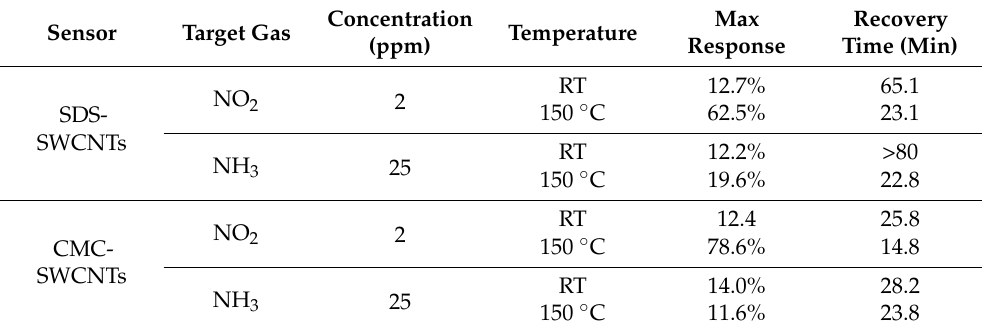
Table 3. Time of recovery needed to reach the value of 1/e of the maximum response of 10 layers of CMC- and SDS-based sensors to the exposure of 2 ppm of NO 2 and 25 ppm of NH 3 at RT and at 150 ◦ C.